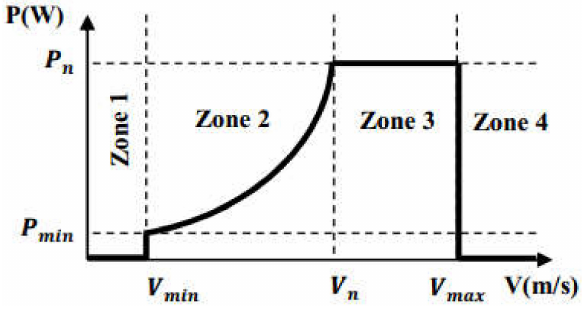
Figure 1. Different operation zones of a wind